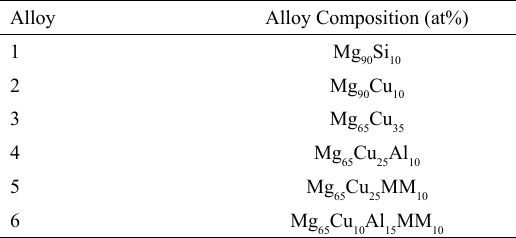
Table 1: Alloys composition (at%) Alloy Alloy Composition